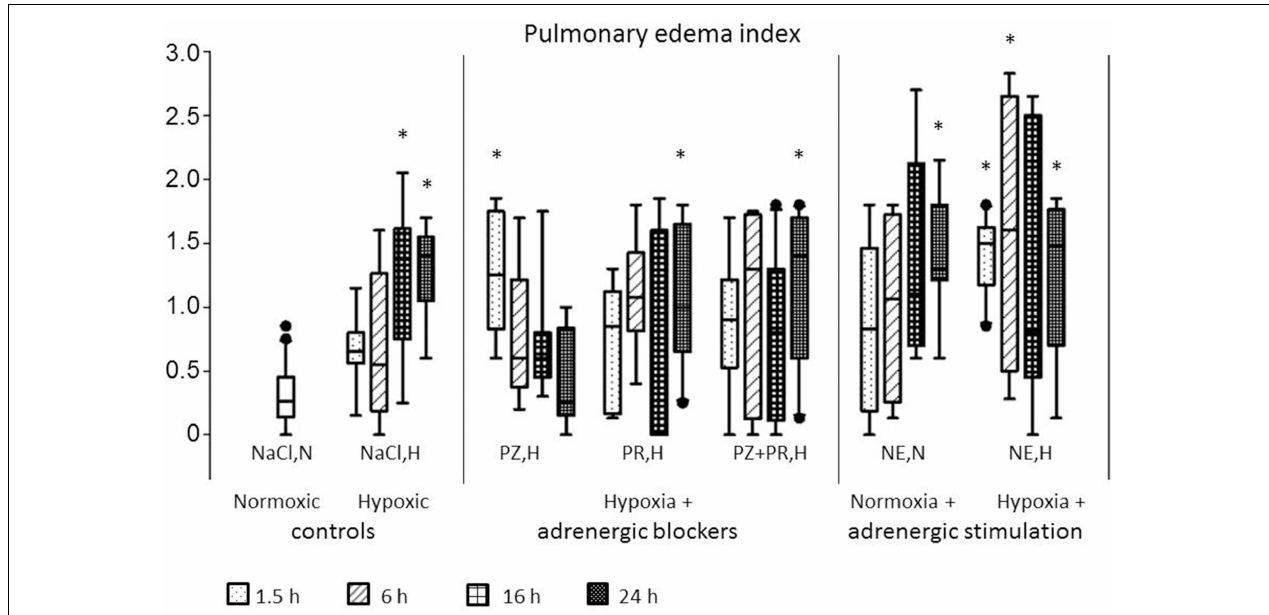
FIGURE 2 | Pulmonary edema index. For abbreviations of treatment groups see Table 1 . Normoxic controls are pooled; in the other treatment groups, the four boxes represent treatments over 1.5, 6, 16, and 24 h, respectively. Data are given as medians (black lines), 25th/75th percentiles (boxes), 10th/90th percentiles (whiskers), and outliers (circles). Significance marks: ∗ significant vs. NaCl,N.